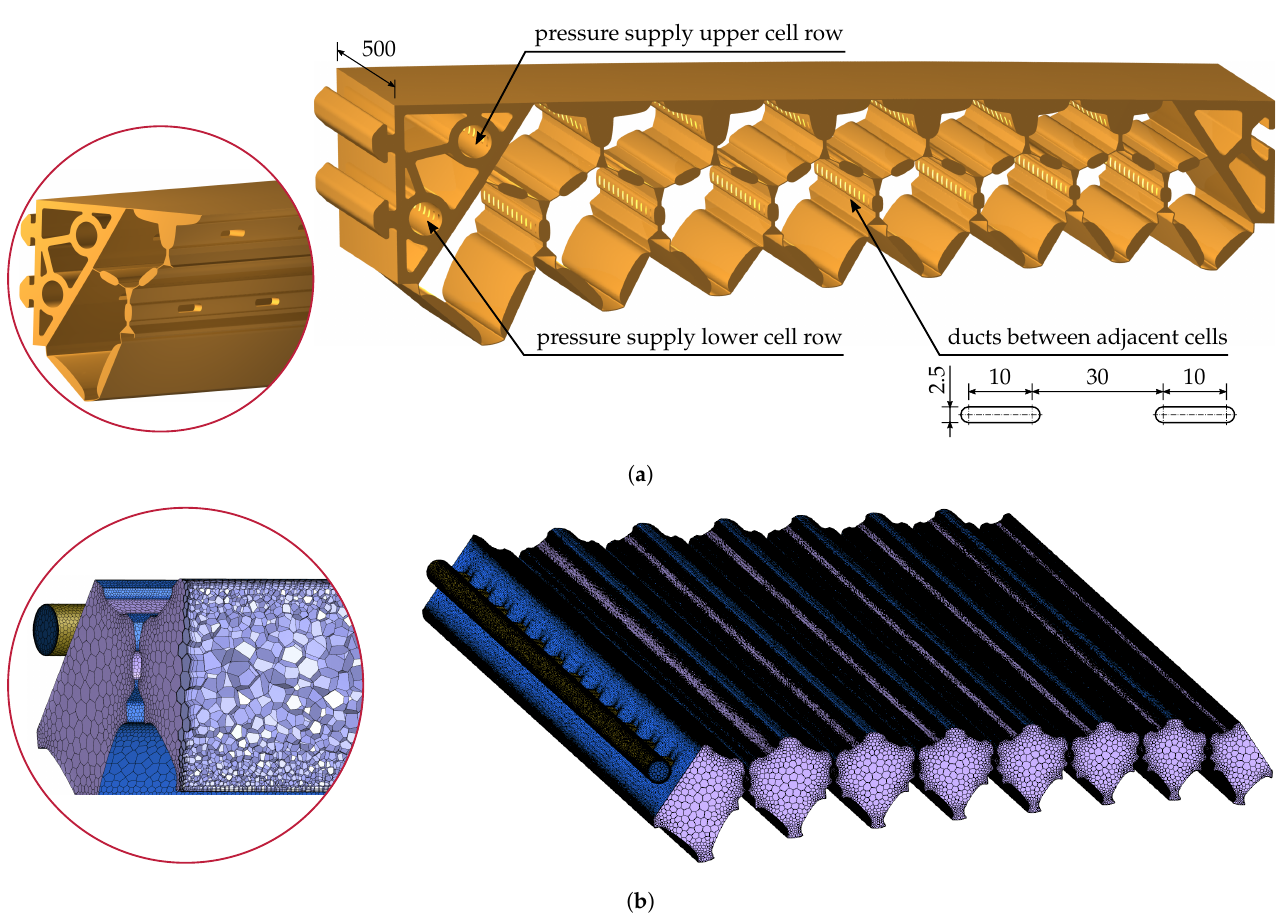
Figure 4. Fluid distribution within the cellular structure: ( a ) Detailed 3D model of the PACS actuator with 500mm depth. Flow channels and mounting interface are structurally integrated. ( b ) Polyhedron mesh of the lower cell row for computa- tional fluid dynamics (CFD), with side cut through second